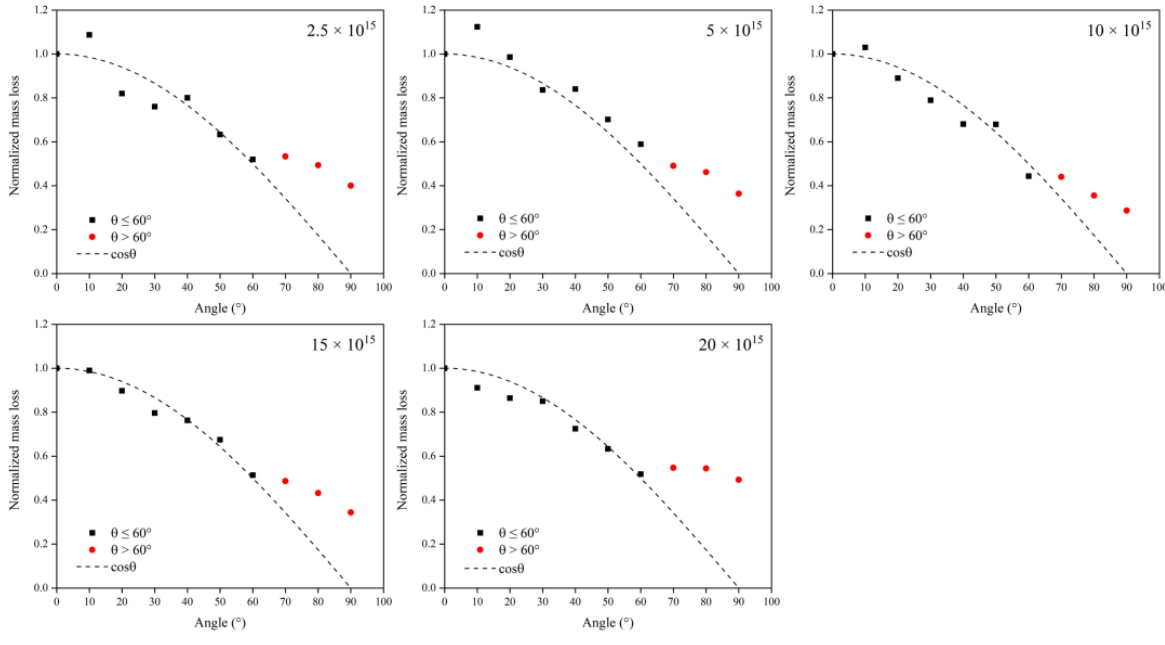
Figure 5. Normalized mass loss of Kapton films versus incidence angle at different flux densities.